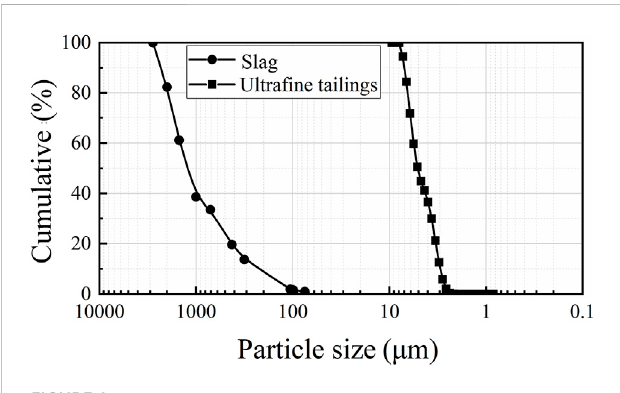
FIGURE 1 Particle size distributions of ultra fi ne tailings and slag